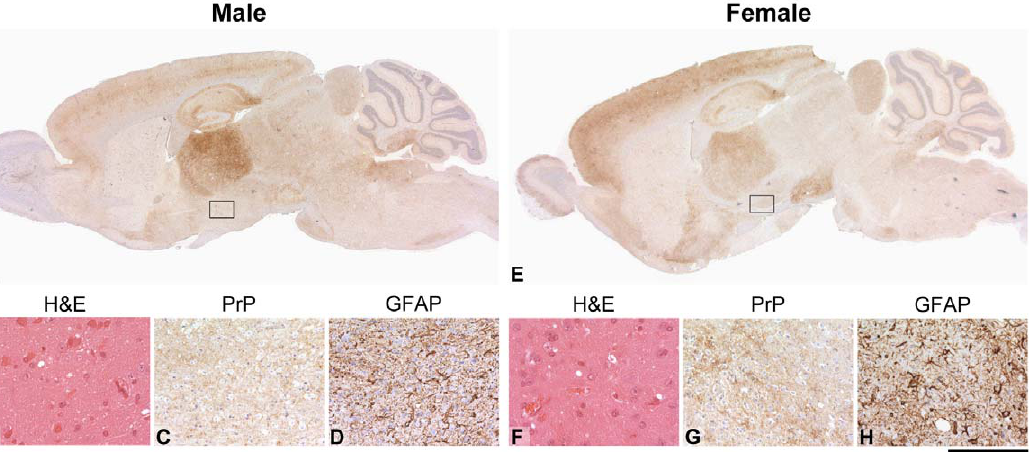
Figure 3. Histological features of Chandler/RML inoculated male and female FVB/N mice. Comparison of histological features between male FVB/N (left panel, A–D) and female FVB/N mice (right panel, E–H) inoculated with Chandler/RML prions. Panels A and E show the PrP Sc distribution in a cross section of the brain and panels B–D and F–H are higher power views of the hypothalamus (boxed area). (B and F) mild spongiosis (C and G) synaptic deposition of PrP Sc (D and H) gliosis. Overall, the pattern of PrP sc distribution, spongiosis or gliosis, shows no difference between both groups. Scale bar corresponds to 2 mm (A, E), 80 m m (B, F) or 160 m m in all other panels.